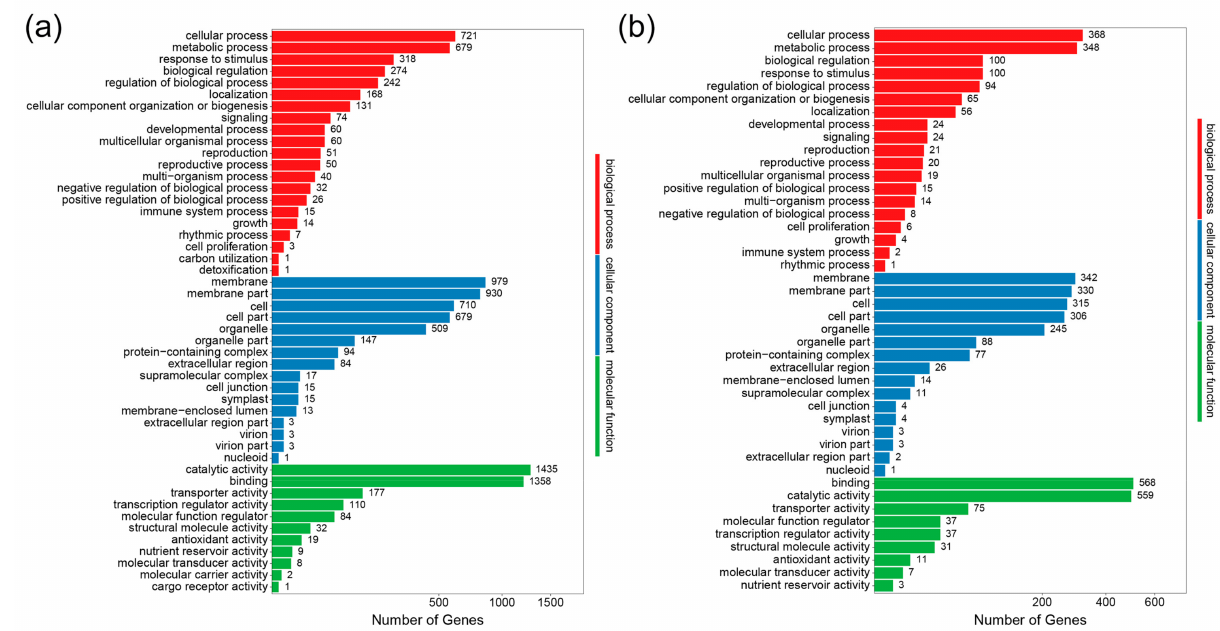
Figure 3. Gene Ontology (GO) enrichment analysis of DEGs in the C-vs-Trp ( a ) and S-vs-S+Trp ( b )